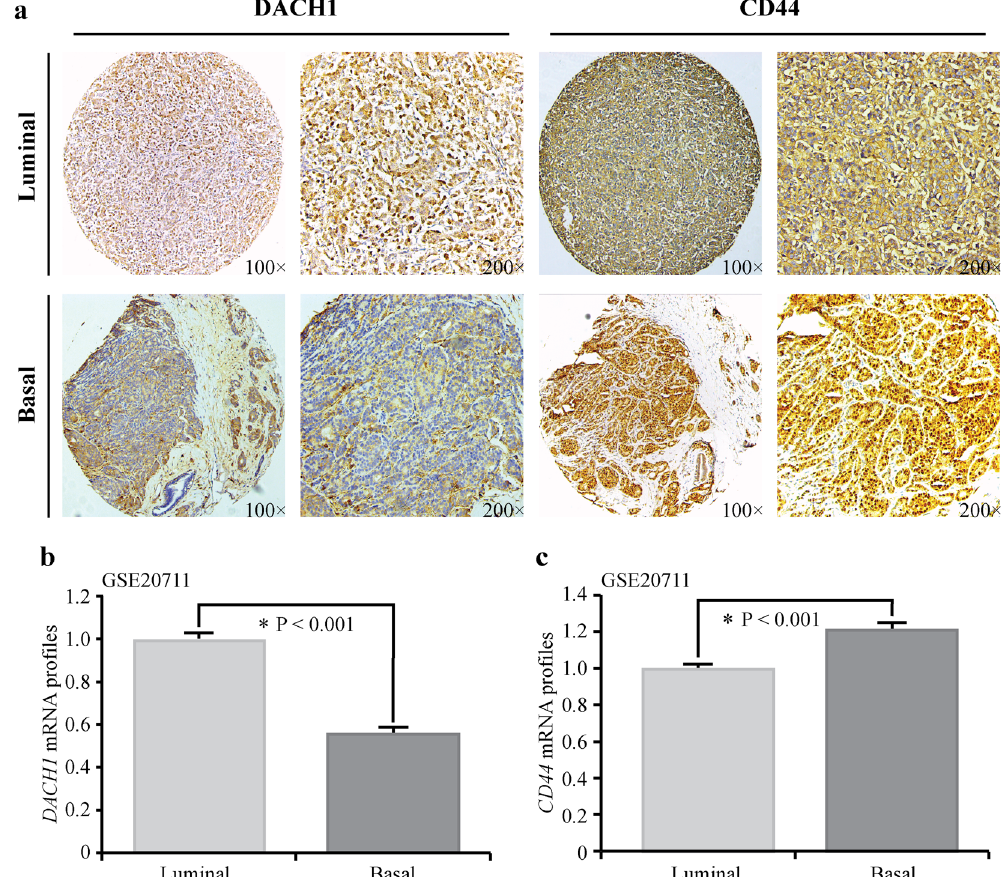
Figure 2. The expression of DACH1 and CD44 correlated with molecular subtypes of breast carcinoma. ( a ) Representative images of immunohistochemistry staining of DACH1 and CD44 in luminal-type and basal- like breast cancer tissues were shown. ( b ) Expression analysis of public microarray dataset GSE20711 showed that the mRNA level of DACH1 was significantly higher in luminal-type than in basal-like breast tumor. ( c ) Expression analysis of GSE 20711 also displayed that CD44 mRNA expression was remarkably lower in luminal- type than in basal-like breast